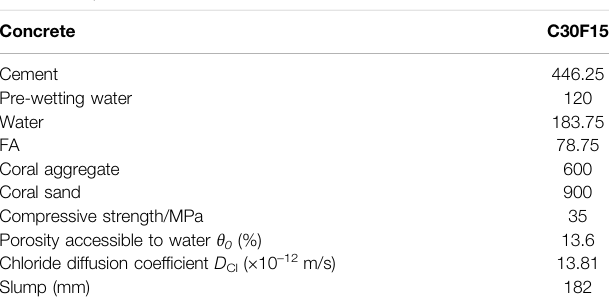
TABLE 3 | Chemical compositions (%) of cement and FA (Huang et al., 2020a; Huang, 2020).